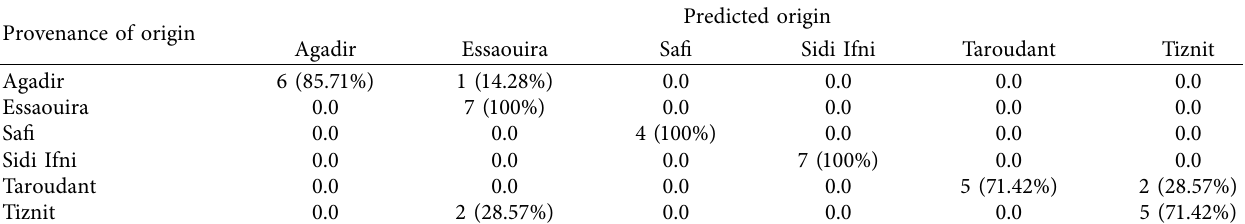
Table 4: Performance of the LDA classification models for the geographical origin